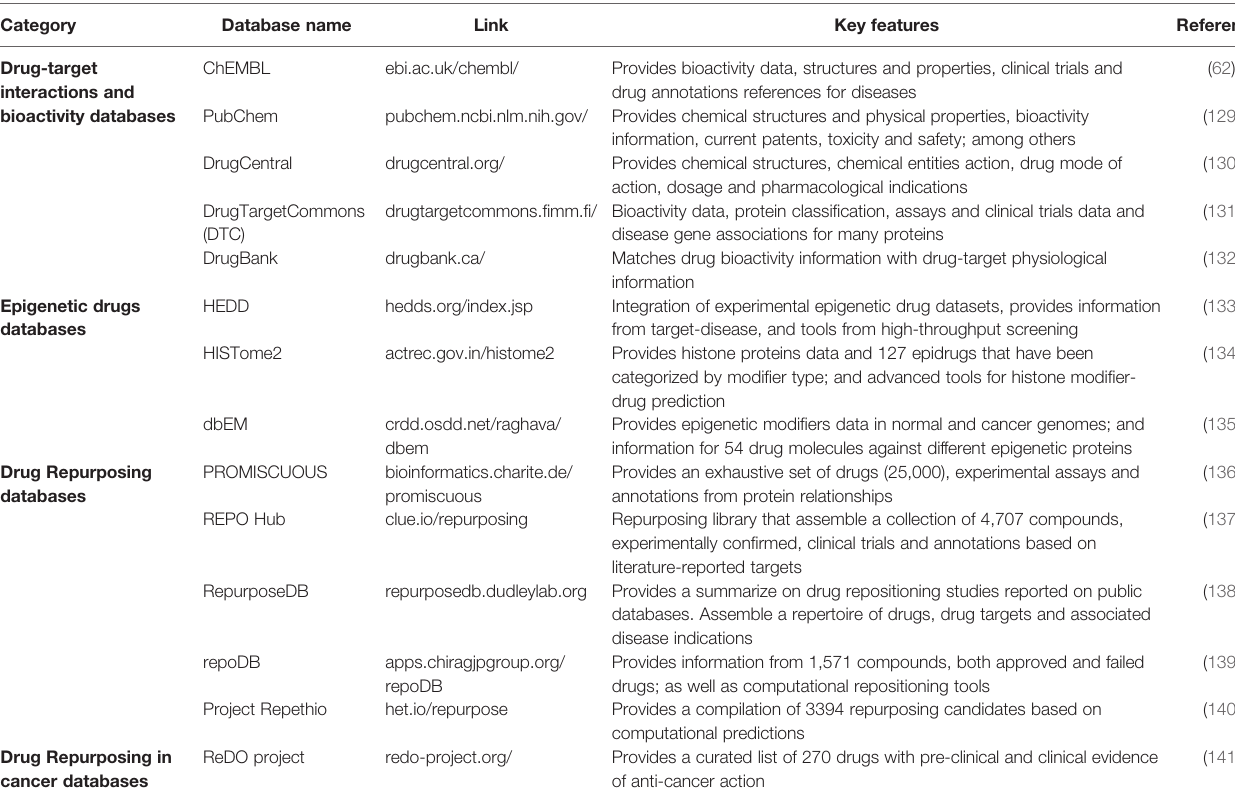
TABLE 3 | Some databases and tools that summarize the current knowledge on